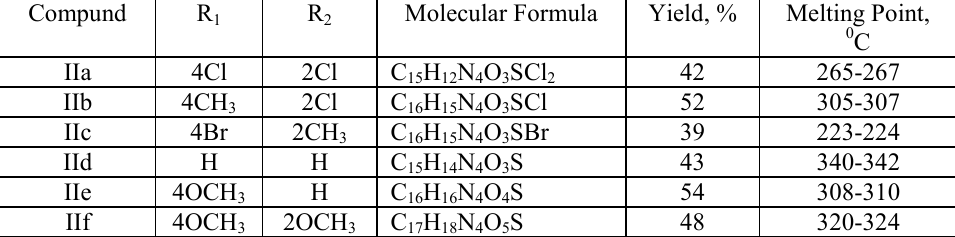
Table 2. Physical and analytical data of compound II and its other substituted derivatives. Compund R R Molecular Formula Yield, 1 2